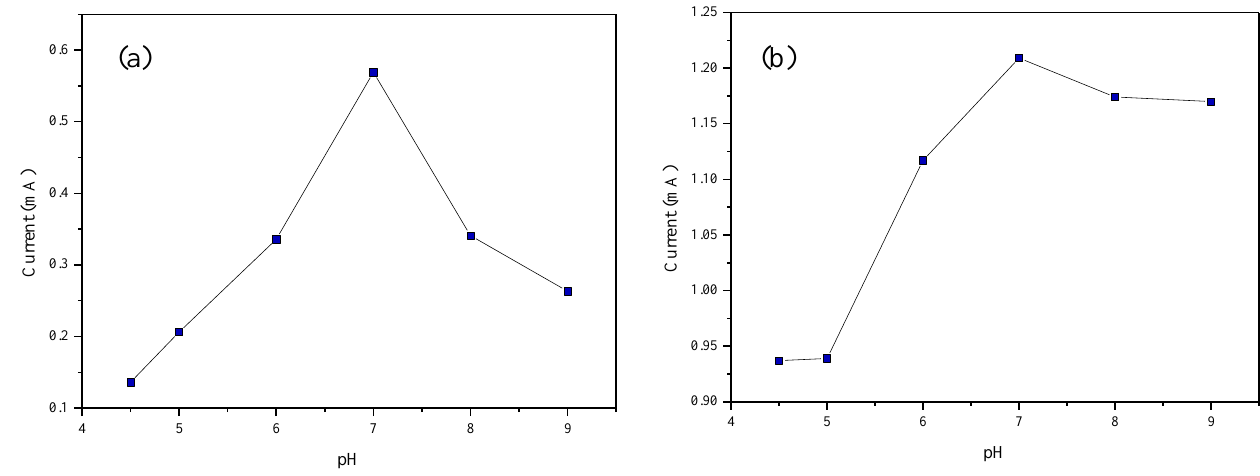
Figure 6. Effect of pH on the microbial biosensor based on CdS-MWNT (a) and